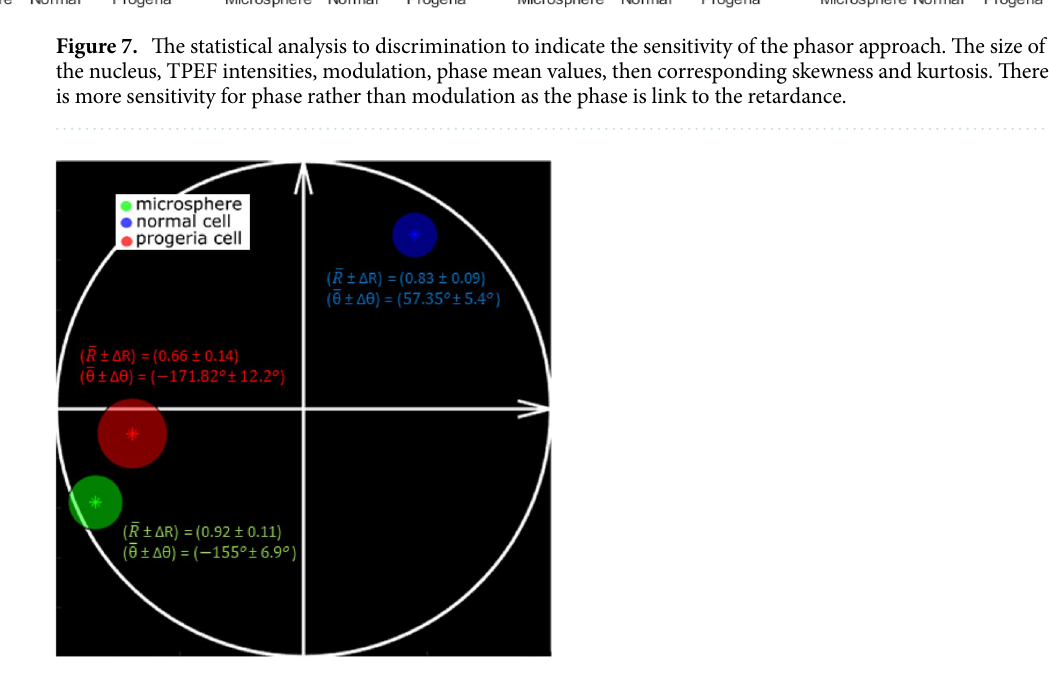
Figure 8. Image phasor map analysis on the statistical information out of microspheres as reference, normal HEK cell and progeria HEK syndrome determined by green, blue and red circles. The center of each represents mean value and the radius shows the